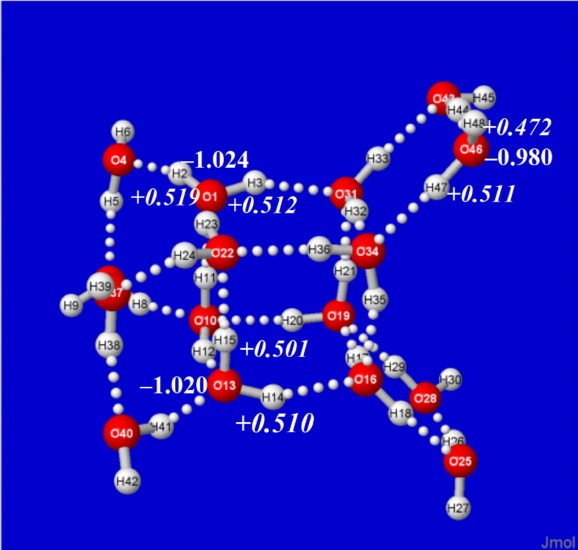
Figure 8. Similar to Figure 7, for representative quadruply ( q -type) coordinated O(1)H(2)H(3) and O(13)H(14)H(15) molecules of the cubane-like core, and doubly ( d -type) coordinated O(46)H(47)H(48) molecule on a bridged wing of the 8,0,8 W 16 cluster. Table 1. Total natural charge Q i and q/t/d coordination type for each water monomer (centered on O( i )) of the 4,4,6 W 16 cluster. (Similar tables are found in SI for each q,t,d W n cluster of the present work).